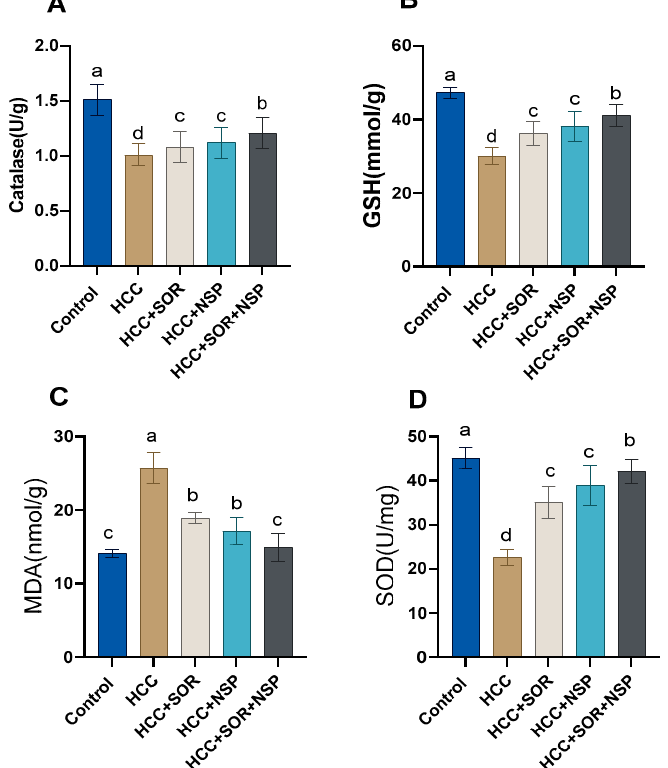
Figure 1. Effects of SOR, NSP, and their combination in DENA-induced HCC on the antioxidant status. ( A ) Catalase; ( B ) GSH; ( C ) MDA; ( D ) SOD. Data are presented as the mean ± SE. a, b, c, d Mean values with different letters differ significantly at ( p ≤ 0.05). ( n = 8).